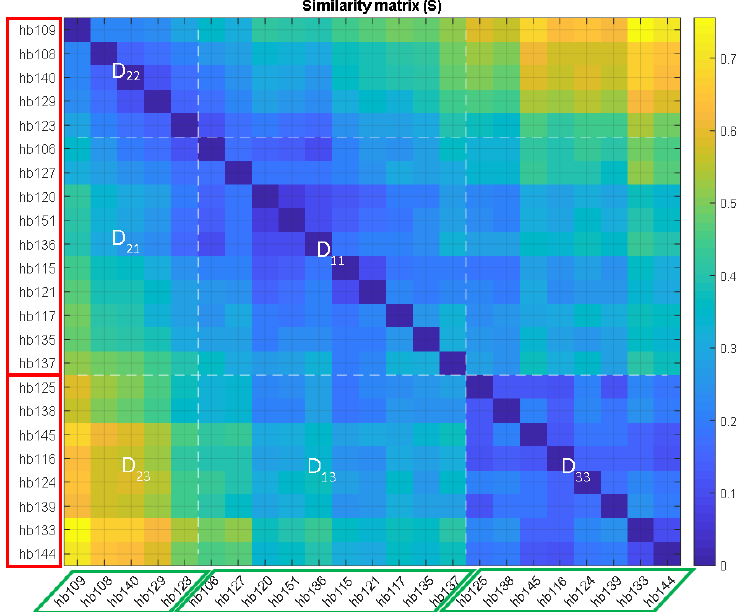
Figure 14. Similarity matrix ( S ) for the urban environment on the weekday. White dashed lines separate three clusters of the Q = 3 clustering solution (marked as green rhomboids at bottom), and the Q = 2 one (also marked on the left-side as red rectangles). Inter ( i = j ) and intra-cluster ( i (cid:54) = j ) distances are highlighted in white and denoted as D ij .